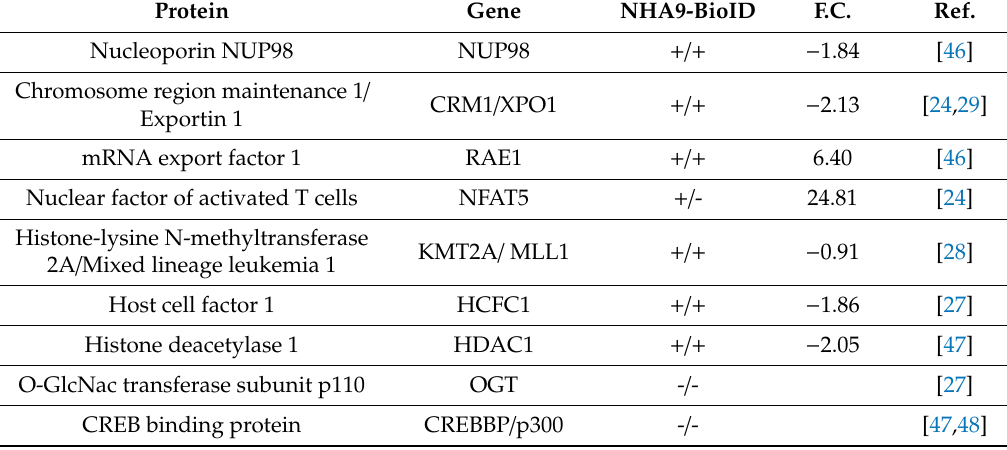
Table 1. List of validated NUP98-HOXA9 interaction partners found in the biotinylated fraction of NHA9-BioID. Protein Gene